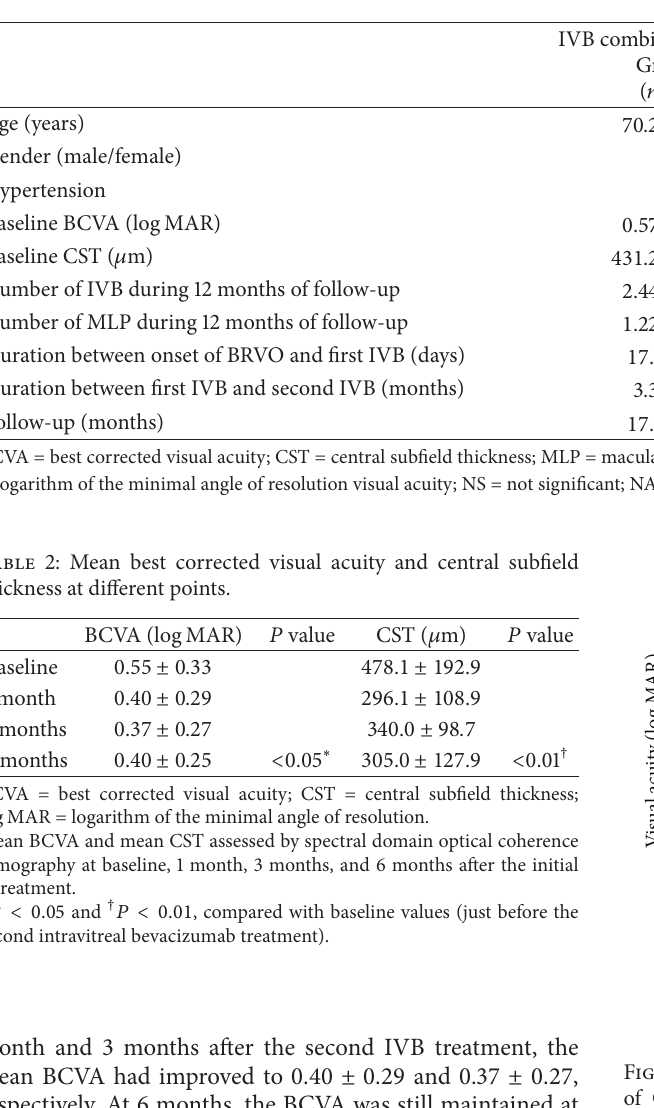
Table 1: Patient characteristics by treatment group.